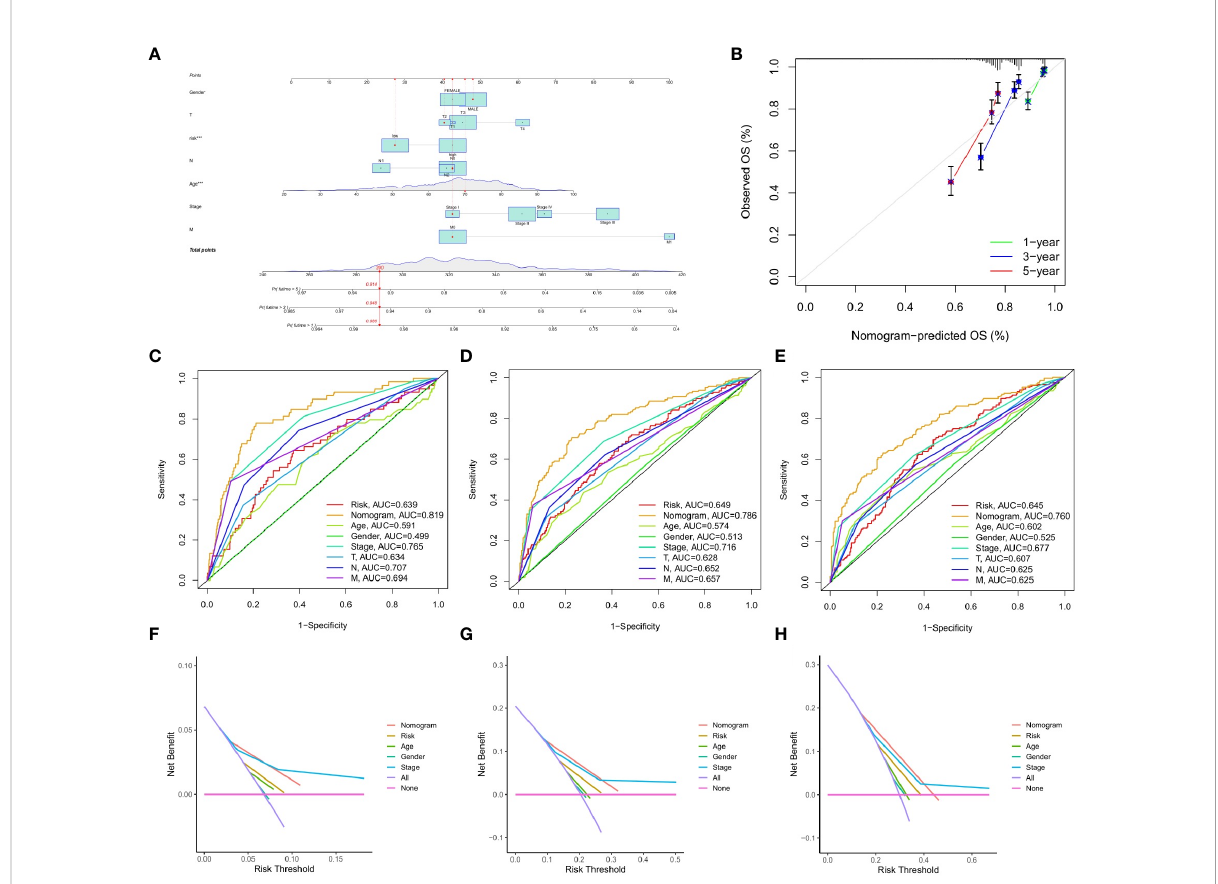
FIGURE 7 Construction and validation of the nomograms. (A) nomogram predicting 1-, 3-, and 5-year OS of COAD patients; (B) Calibration curve of the nomogram; (C – E) The ROC curves used to predict 1-, 3-, and 5-year of OS; (F – H) The DCA curves used for predicting the OS at 1-, 3-, and